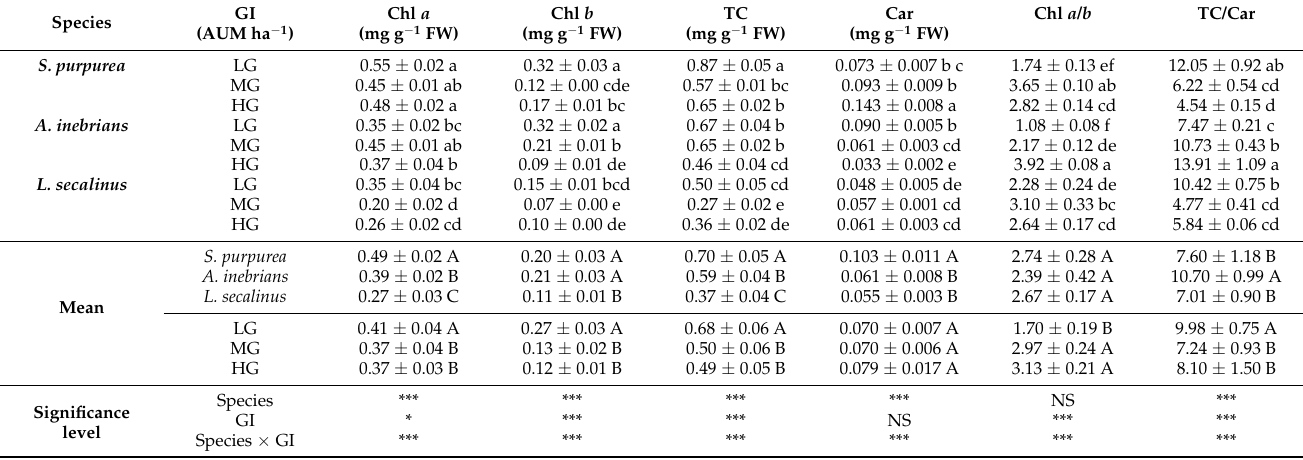
Table 2. Effects of different species and grazing intensities on spike chlorophyll